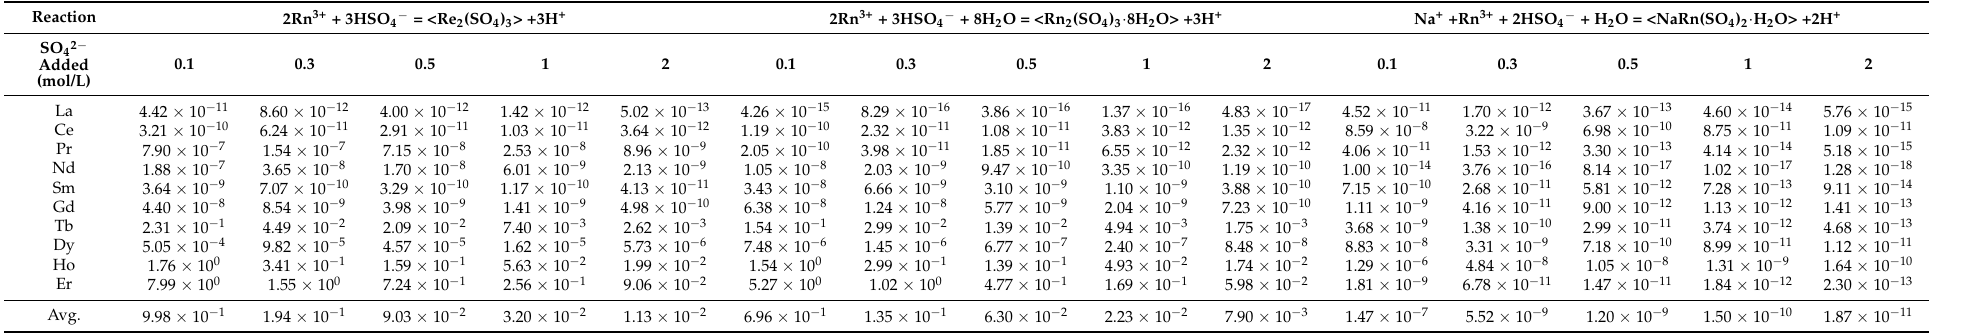
Table 5. Concentration of Rn 3+ in equilibrium with three sulfate precipitates; anhydrous, octa-hydrated, and sodium double salt at pH 3 with H 2 SO 4 .